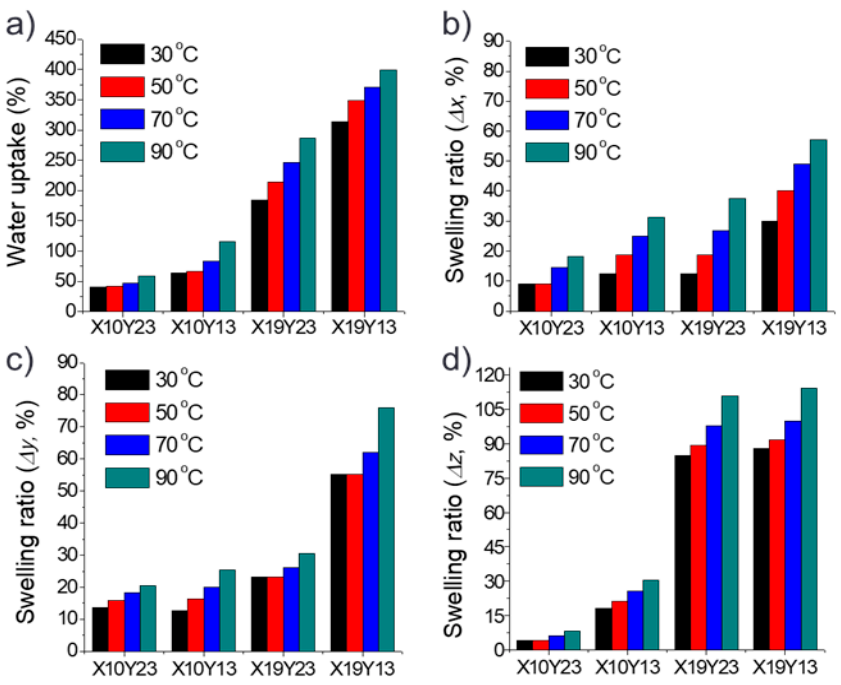
Figure 6. The ( a ) water uptake and dimensional stabilities (swelling ratio of ( b ) width ( ∆ x ), ( c ) length ( ∆ y ), and ( d ) thickness( ∆ z )) of QN-PAES membranes. Table 4. IEC, hydroxide conductivity, and activation energy ( E a ) of QN-PAES membranes. Membrane